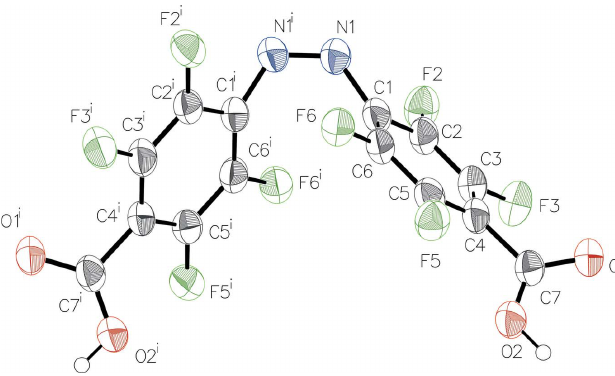
Figure 2 The molecular structure of (II) showing the atom labelling and displacement ellipsoids drawn at the 50% probability level. H atoms are drawn as spheres of arbitrary radius. [Symmetry code: (i) (cid:4) x + 1, y , (cid:4) z + 1 ]. 2